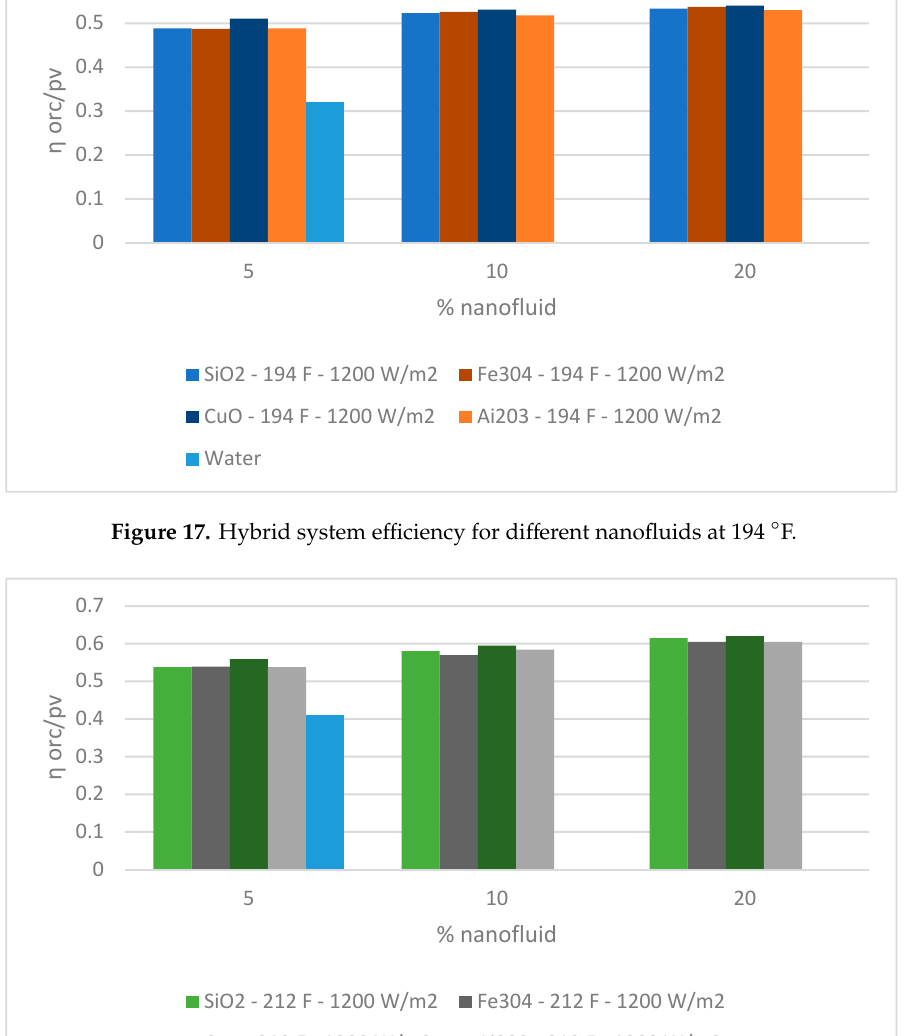
Figure 16. Hybrid system efficiency for different nanofluids at 176 ◦ F